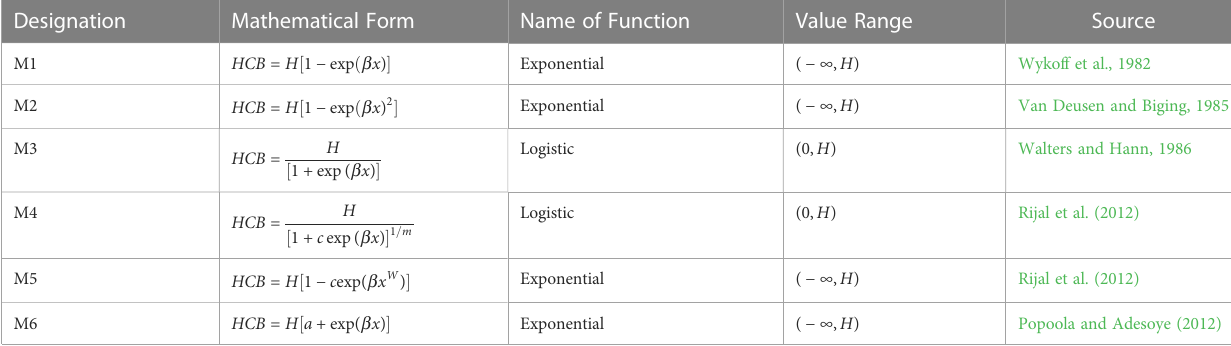
TABLE 2 HCB candidate models considered (HCB: height to crown base; H: bamboo height; x: vector of bamboo variables; b , a, c, 1/m and W: parameter vector; ∞ : in fi